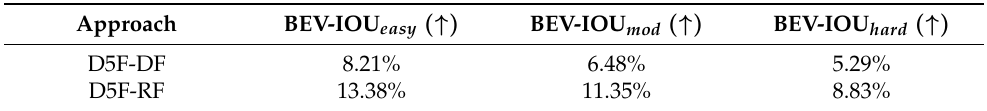
Table 4. Average precision in terms of BEV-IOU for three difficulty levels (BEV-IOU easy , BEV-IOU mod , and BEV-IOU hard ).